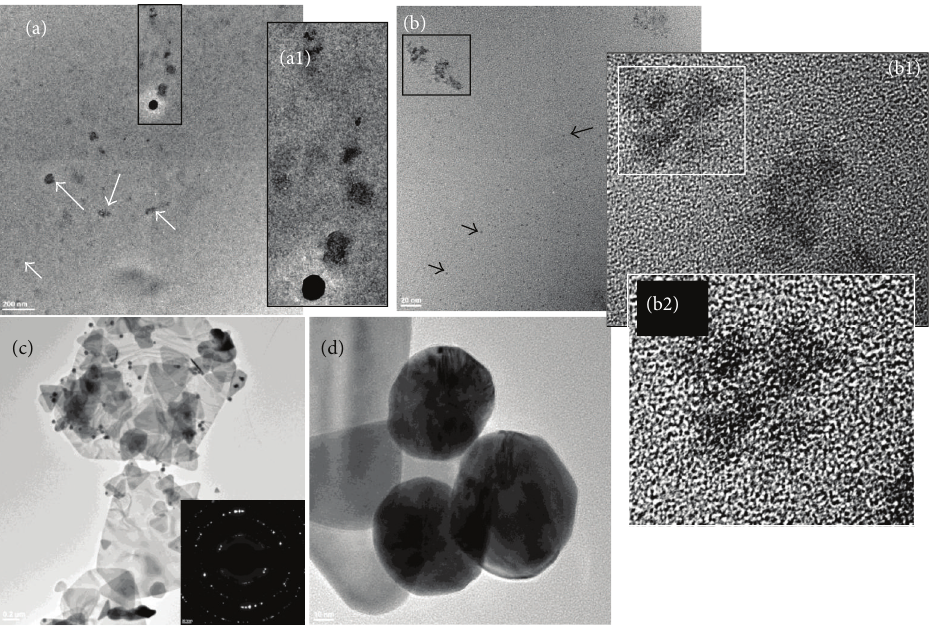
Figure 7: TEM and HR-TEM micrographs characteristic for Au-G6-10 at 60 minutes after preparation ((a), (b)) and at 48 hours after preparation ((c), (d)). The general appearance of the sample after 60 minutes contains two types of areas: (a) few spheroidal particles accompanied by numerous metal agglomeration inside clusters of dendrimers (as indicated by white arrows) and (b) preorganization areas with limited number of metal atoms inside dendrimer cages and metal accumulations outside dendrimers (as shown by black arrows). (a1) Detailed view of the marked area from image (a), showing the metal domains accumulated in one dendrimer molecule. (b1) Detailed view of the marked area from panel (b). (b2) Zoomed area from image (b1). (c)-(d) After 48 hours, two types of crystalline phases exist: spheroidal particles and crystalline structures developed through unhindered growth. Inset represents SAED image characteristic for gold (fcc).